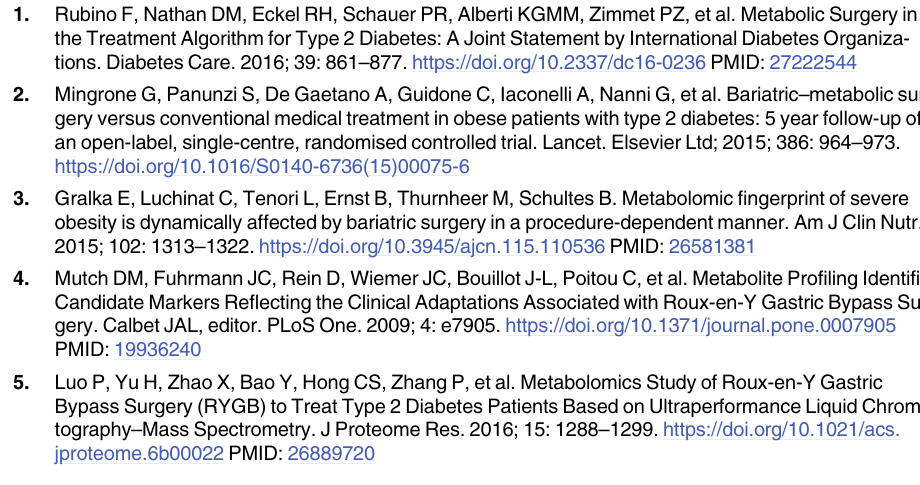
S8 Table. Raw data with clinical and metabolomic variables in each period of